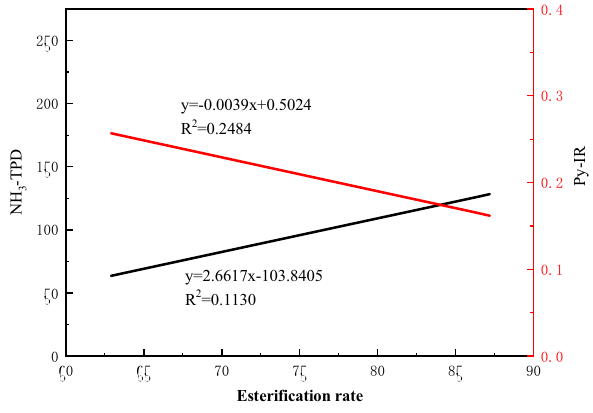
Figure 7: Linear fi t results of the response to di ff erent loadings.